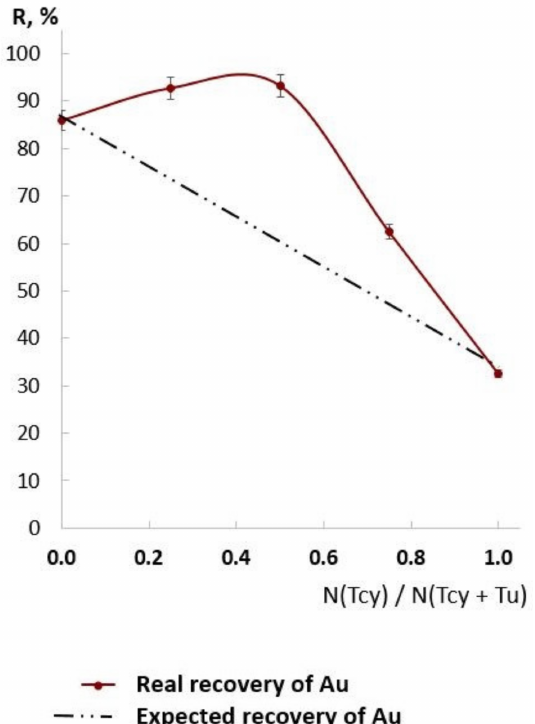
Figure 5. The isomolar series of desorption of Au using thiourea–thiocyanate mixture in 0.2 M HCl ( n = 3, p = 0.95). The sum of molar concentrations of thiourea and thiocyanate was equal to 0.5